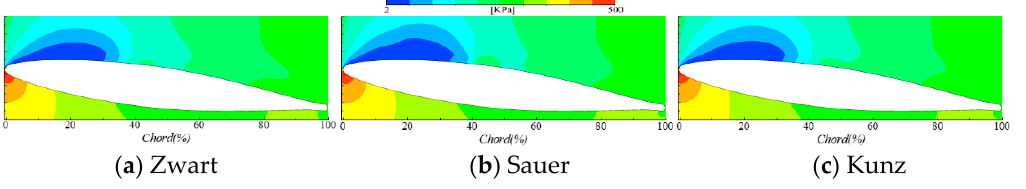
Figure 9. Contours of (cid:1868)̅ predicted with the different cavitation models.